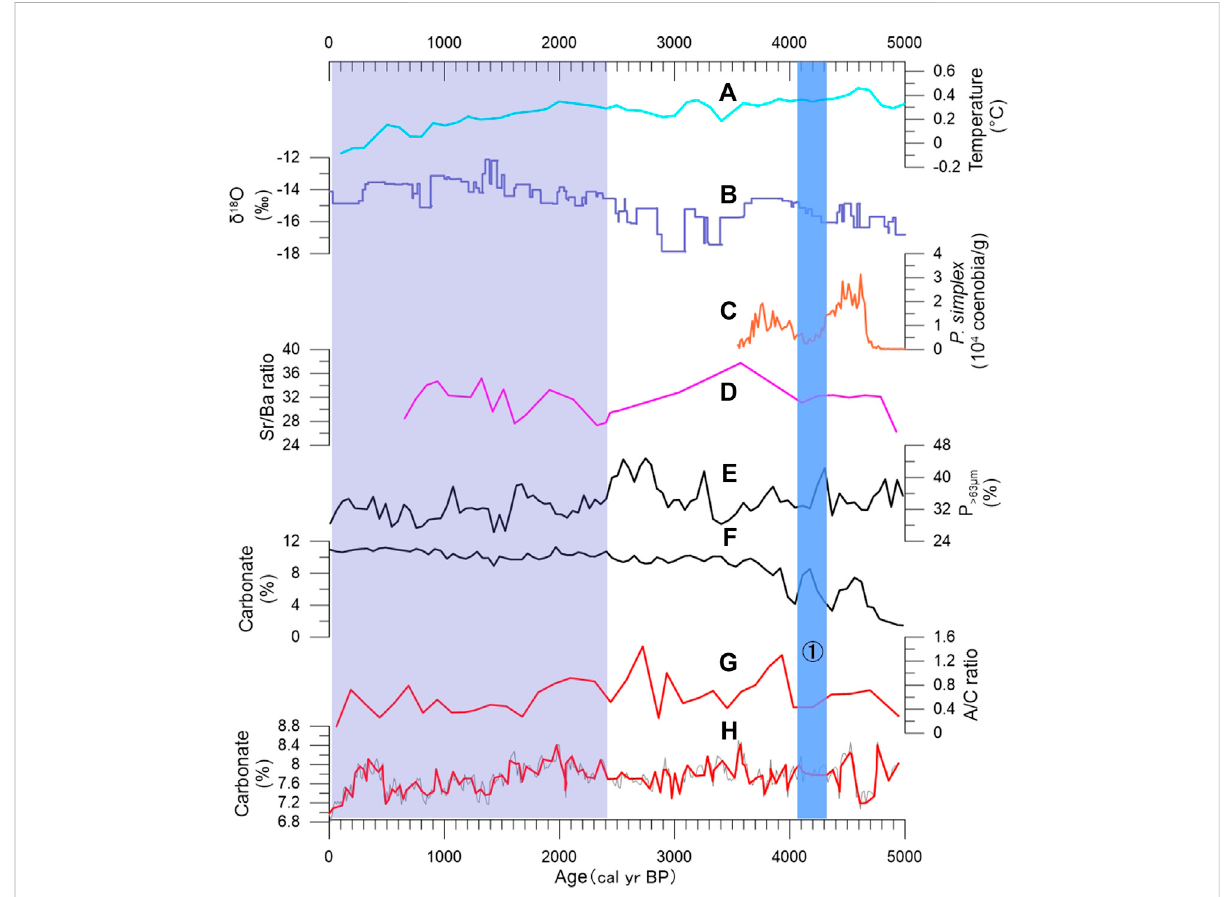
FIGURE 6 ComparisonofclimaticrecordsofthesurroundingareaandKLAloessdata. (A) MeanannualtemperaturereconstructionforNorthAmericaand Europe(Marsiceketal.,2018). (B) δ 18 OrecordfromtheGuliyaicecore(Thompsonetal.,1997). (C) Concentration of P.simplex inBostenLake(Huang et al., 2021). (D) Sr/Ba record of Yotgan pro fi le (Zhong et al., 2007). (E) p > 63 μ m sand content of the Liushui cemetery (Tang et al., 2009). (F) Carbonate content of the Liushui cemetery. (G) The ratio of Artemisia to Chenopodiaceae (A/C). (H) Carbonate content of KLA section. ① Indicate cold events at 4.2 – 4.1 kyr, respectively. Blue shading represents historical